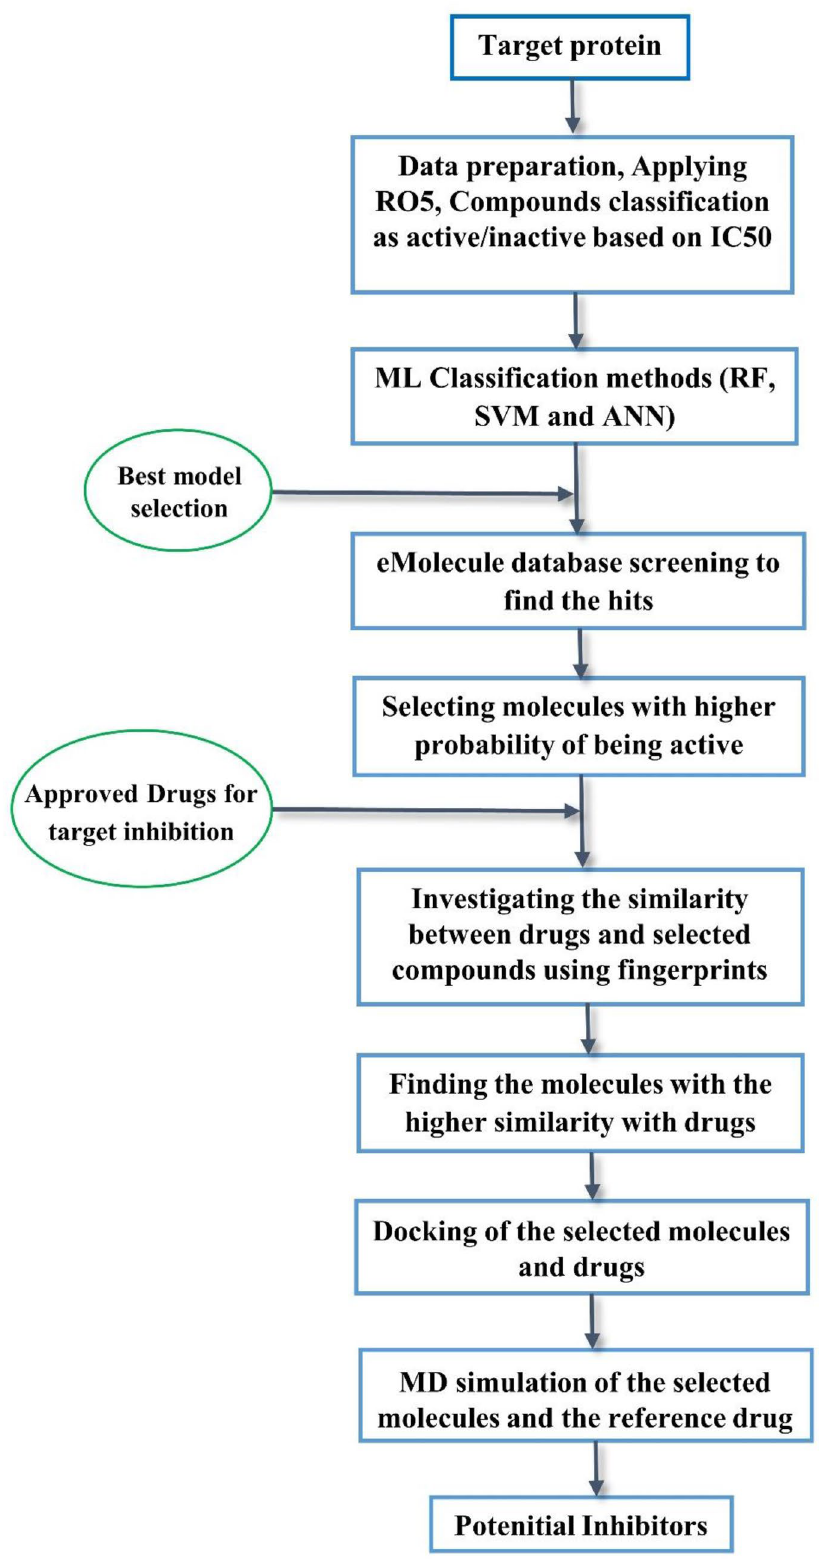
Figure 2. Detailed workflow of the study to find potential